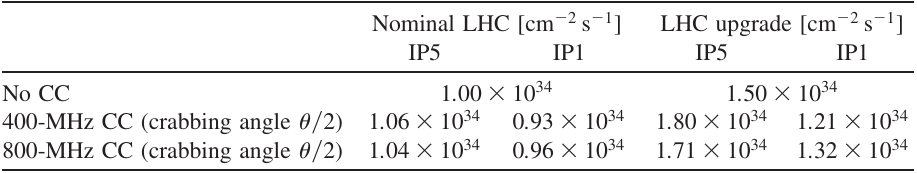
TABLE IV. Luminosity simulated by GUINEA-PIG for different global crabbing cases with only one global crab cavity [similar luminosity gain (IP5) and loss